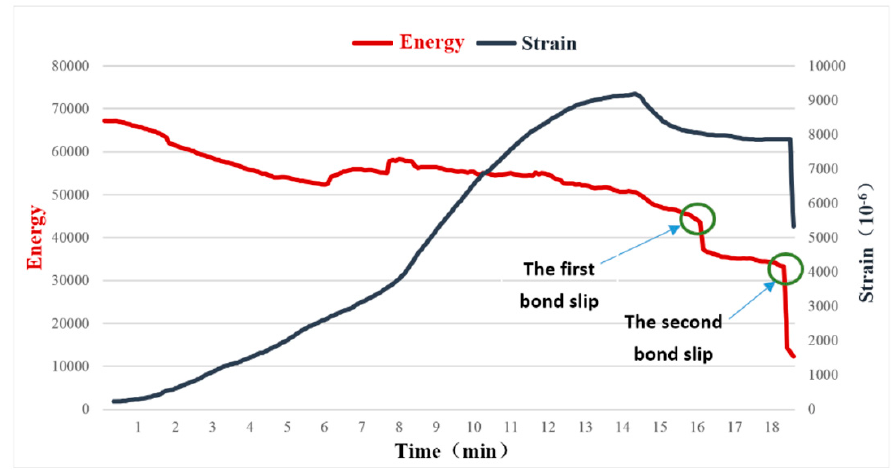
Figure 8. The energy and strain curves of the 5D specimen (experiment 1).